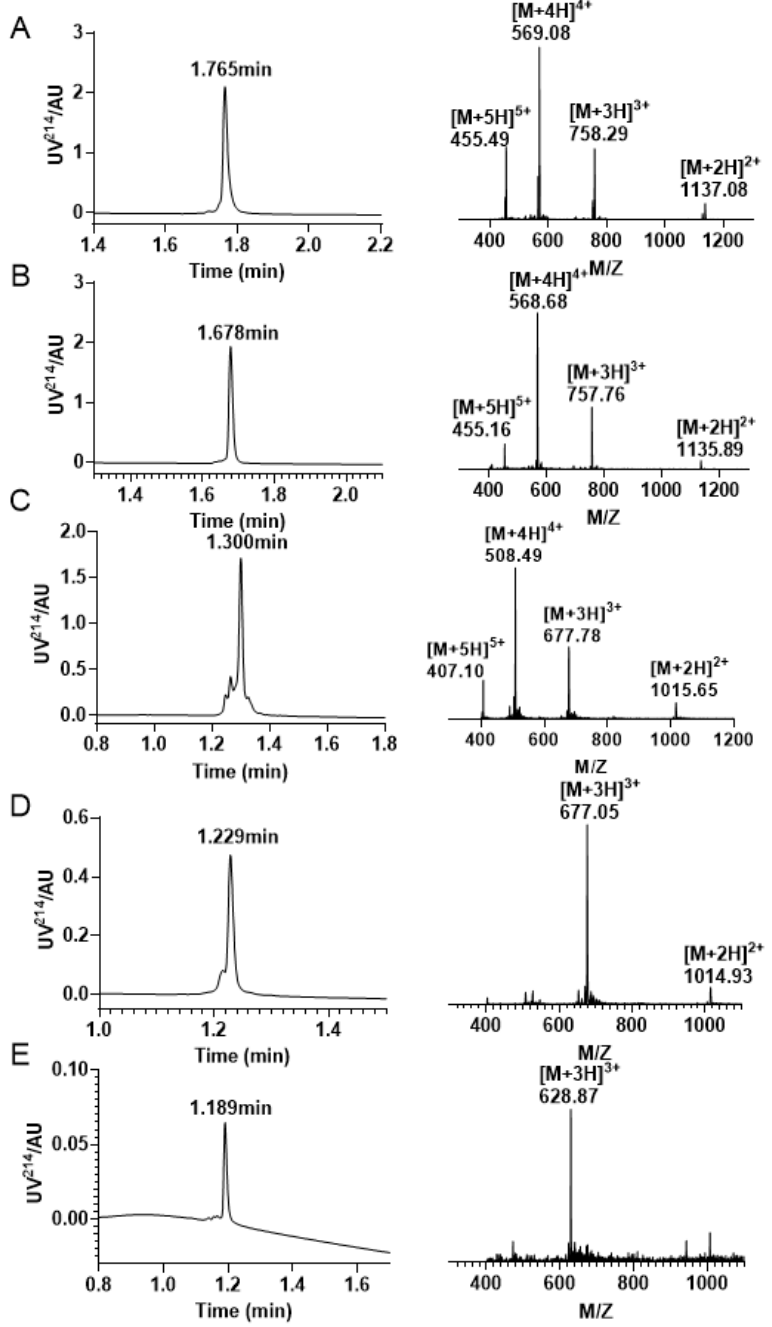
Figure 9. RP − UPLC and mass spectrogram were monitored at every step of the reaction during the Acm/Mob/Trt strategy folding. ( A ) The RP − UPLC and ESI − MS diagram after resin purification, with a retention time of 1.765 min and a mass of 2271.87 Da. ( B ) The RP − UPLC and ESI − MS diagram after the initial disulfide bond formation between Cys4 —Cys16, with a retention time of 1.678 min and a mass of 2270.28 Da. ( C ) The RP − UPLC diagram and ESI-MS diagram of the purified product after Mob protecting group removal, with a retention time of 1.300 min and a mass of 2030.34 Da. ( D ) The RP − UPLC diagram and ESI-MS diagram after the second disulfide bond is formed between Cys2 —Cys9, with a retention time of 1.229 min and a mass of 2028.15 Da. ( E ) The RP − UPLC diagram and ESI − MS diagram of the third pair of disulfide bonds formed by Cys1 —Cys15, with a retention time of 1.189 min and a mass of 1883.61 Da.